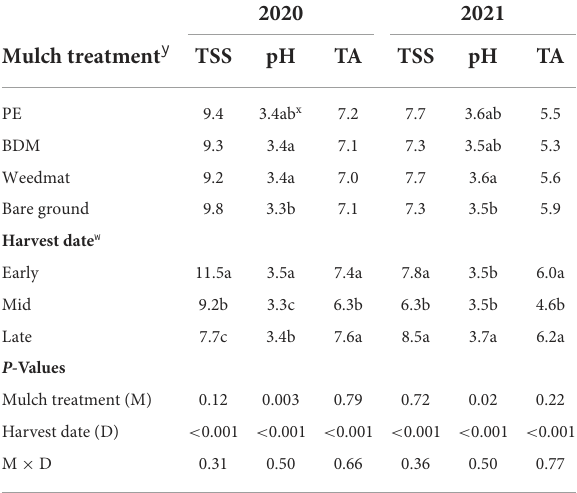
TABLE 4 Total soluble solids concentration (TSS, %), juice pH, and titratable acidity (TA; citric, g · L − 1 ) of strawberry fruits cv. Albion harvested from plants grown on raised beds with polyethylene (PE), soil-biodegradable mulch (BDM), weedmat, or bare ground